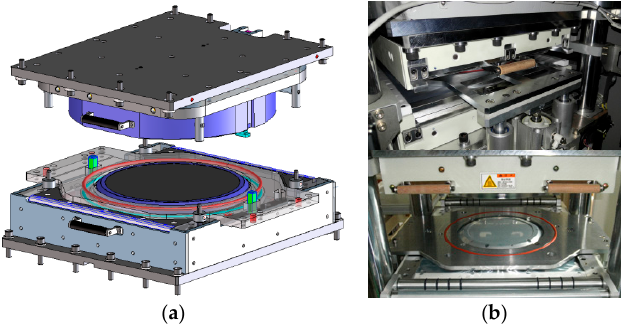
Figure 5. Compression molding die set: ( a ) design of the molding die set; ( b ) manufactured molding die set.